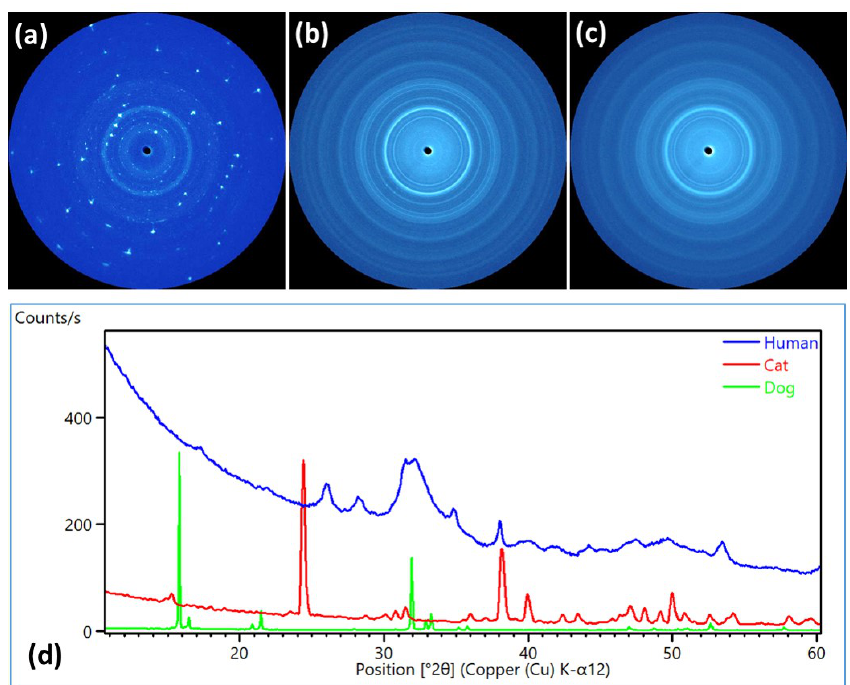
Figure 2. The 2D diffraction patterns of the stone samples from ( a ) dog, ( b ) cat, and ( c ) human urinary stone samples. ( d ) The 1D diffraction profiles of the three